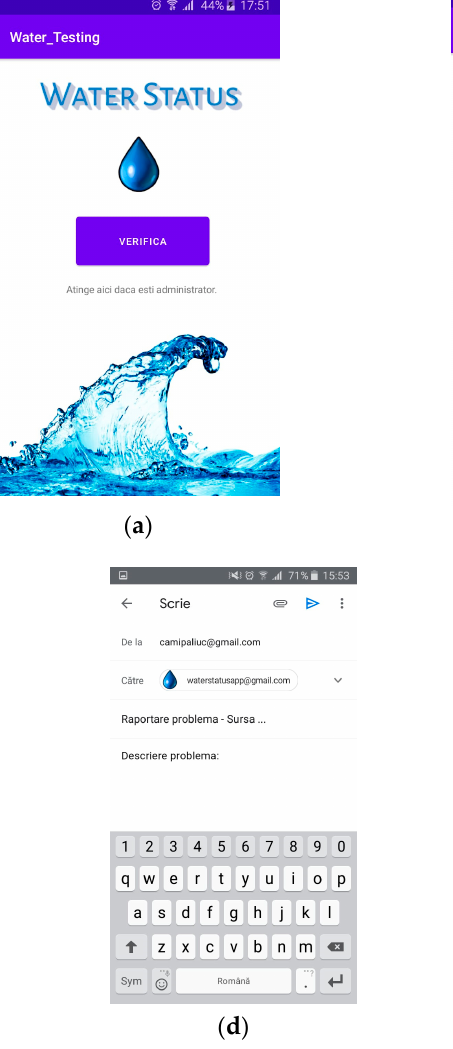
Figure 7. Graphical user interfaces for: ( a ) the main activity; ( b ) a certain water source; ( c ) finding the water sources in the locality; ( d ) issue reporting; ( e ) water-source retest activity